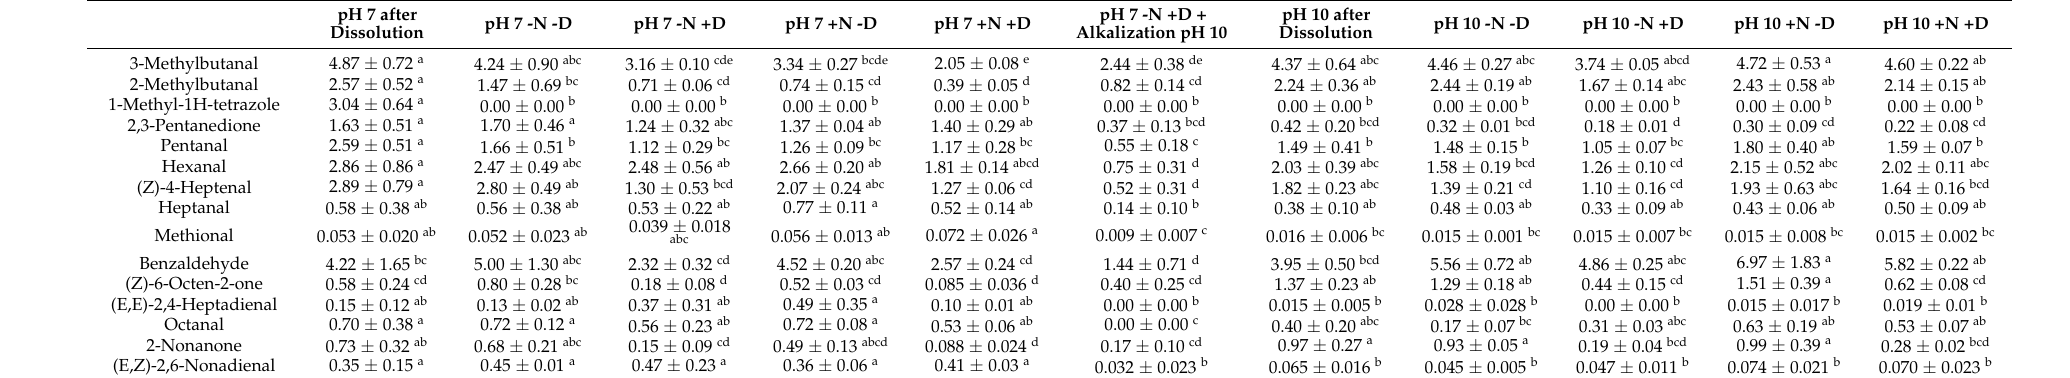
Table 2. Abundance of the most potent odor-active compounds of HMH (x10 7 Arbitrary Unit (U.A.)) after dissolution and after the different treatments (mean ± standard